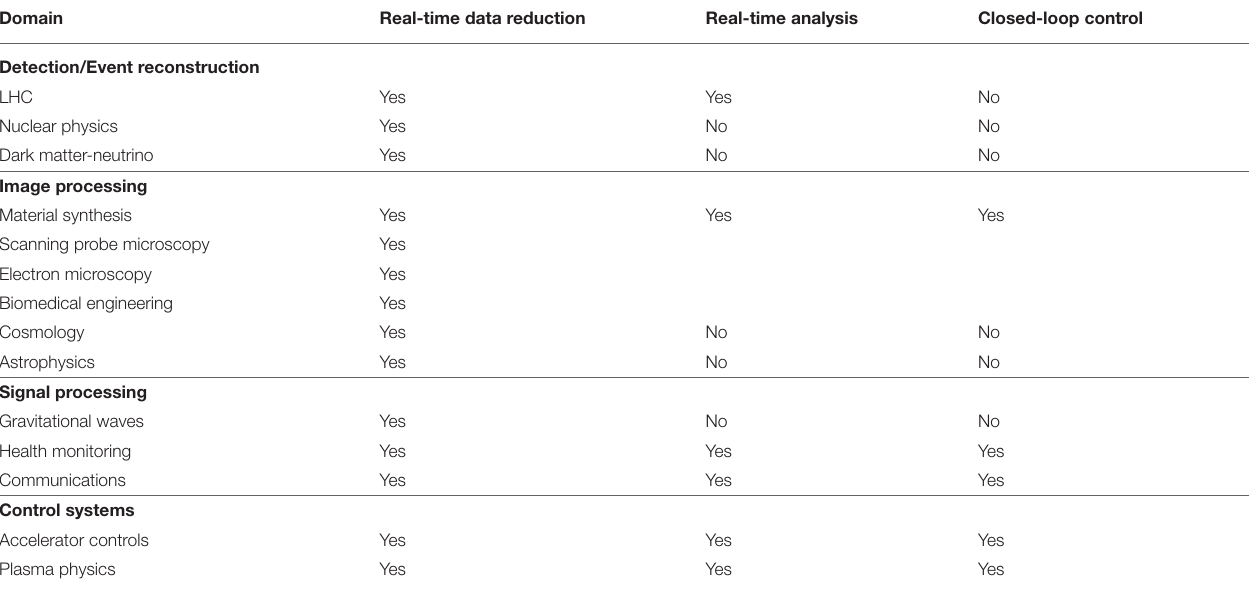
TABLE 3 | Classification of domains and their system requirements with respect to real-time